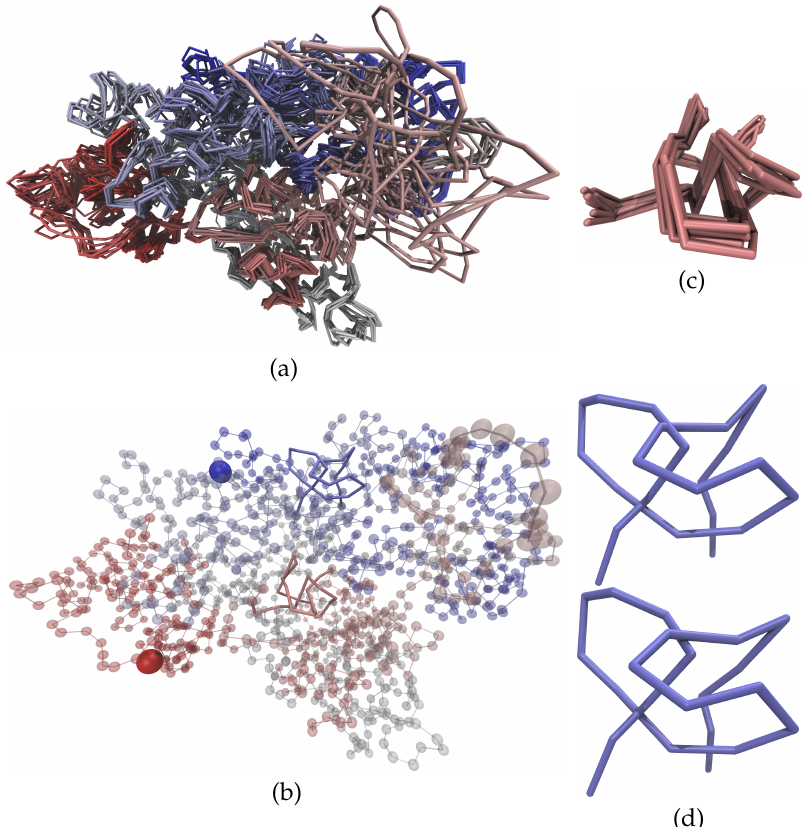
Figure 4. Structure of chromosome 14 from cell 2 [48]. Panel ( a ) shows a comparison of all 10 models of the complete chromosome; whilst panel ( b ) shows one of those models (model 3), which contains two trefoil knots; Panel ( c ) shows an expanded view of one of the regions that forms a knot. Generally, the different models show a remarkable consistency. This corroborates our belief that the experimentally measured contacts define a non-degenerate ground state that is properly determined by the annealing procedure [48]. However, it is worth noting that there are also loops of the chromosome at the nuclear surface that do not exhibit many contacts. One example is the salmon colored loop in the top right of panel ( a ). Due to a lack of contacts this loop is not in a well-defined ground state but differs rather strongly between different models. In contrast, the two regions discussed in this paper do exhibit a well-defined structure. In panel ( b ), model 3 is represented as transparent beads with the knotted regions highlighted by solid lines—termini are accentuated by large solid beads. The red knot as shown in panel ( c ) has a very well-defined structure in all the models. In combination with the comparably large separations between the arcs of the knots, this leads to a consistent topology for all models. The structure of the blue region shown in panel ( d ) differs more strongly between the different models. In the upper center of the structure the separation between two of the arcs is very small. This leads to differences in the topology for different models as the trefoil knot that is present in some of the models (e.g., in the upper structure) can easily vanish (as shown in the lower structure) when the two arcs exhibit only a small relative change in their